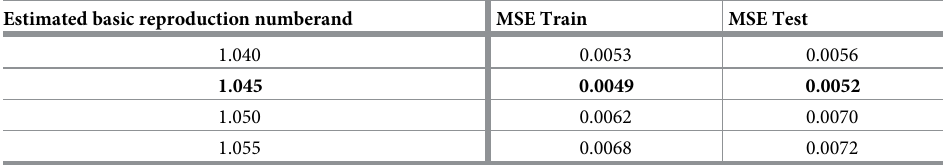
Table 7. The MSE value of ANN-BTA network after interval limiting [1,1.2] and obtaining the lowest error rate in estimating basic reproduction